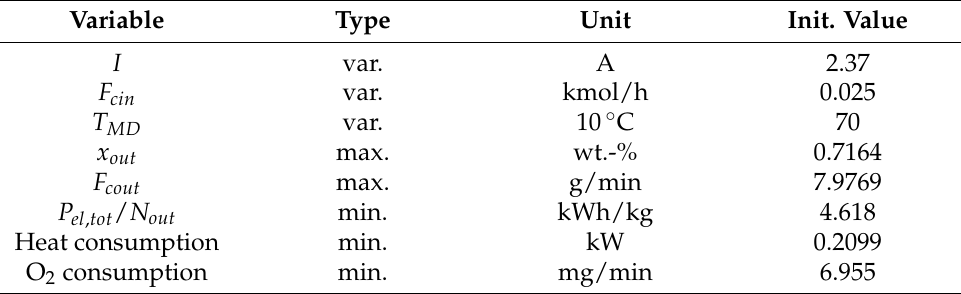
Table 4. Configuration of the MCO problem for optimization of working points for the process producing H 2 O 2 represented by the flowsheet displayed in Figure